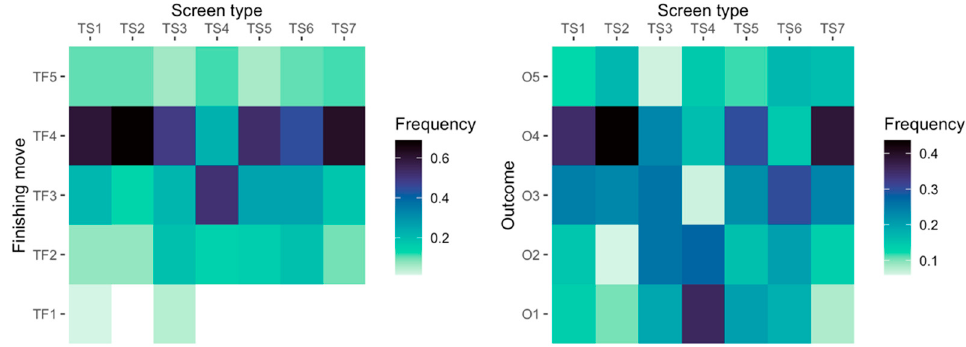
Figure 2. Heatmap of the relationship between screen type/finishing move and screen type/outcome.